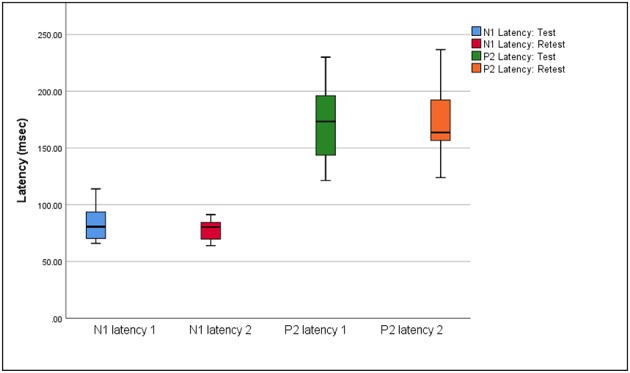
Median, interquartile range, minimum, and maximum N1 and P2 latencies at test and retest (n = 12).